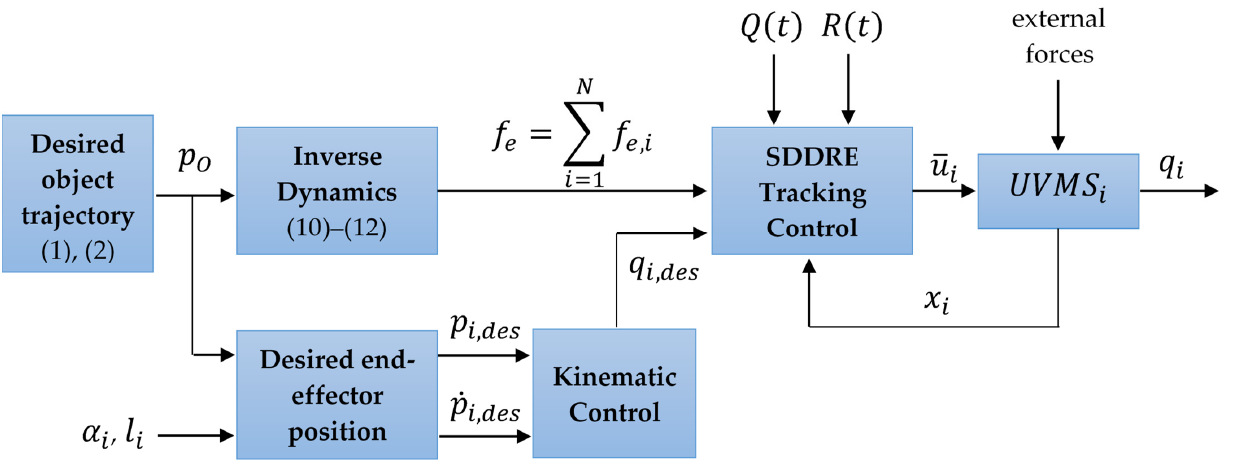
Figure 2. UVMS’s tracking control